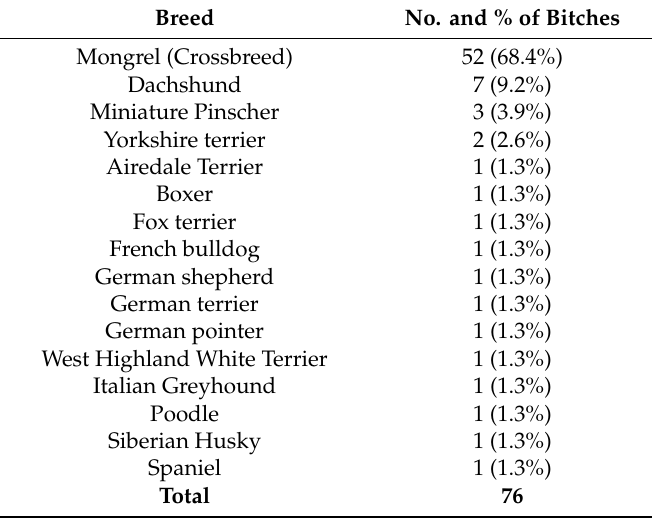
Table 2. Numbers and percentage of particular breeds among examined bitches presented with dystocia after unwanted mating ( n = 76).